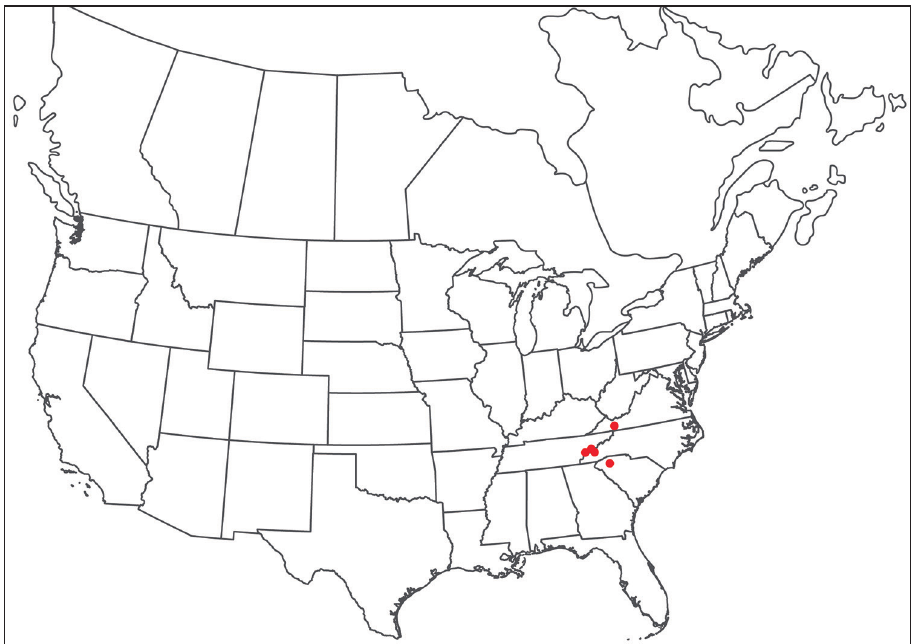
Figure 61. Torrenticola dunni sp. n.